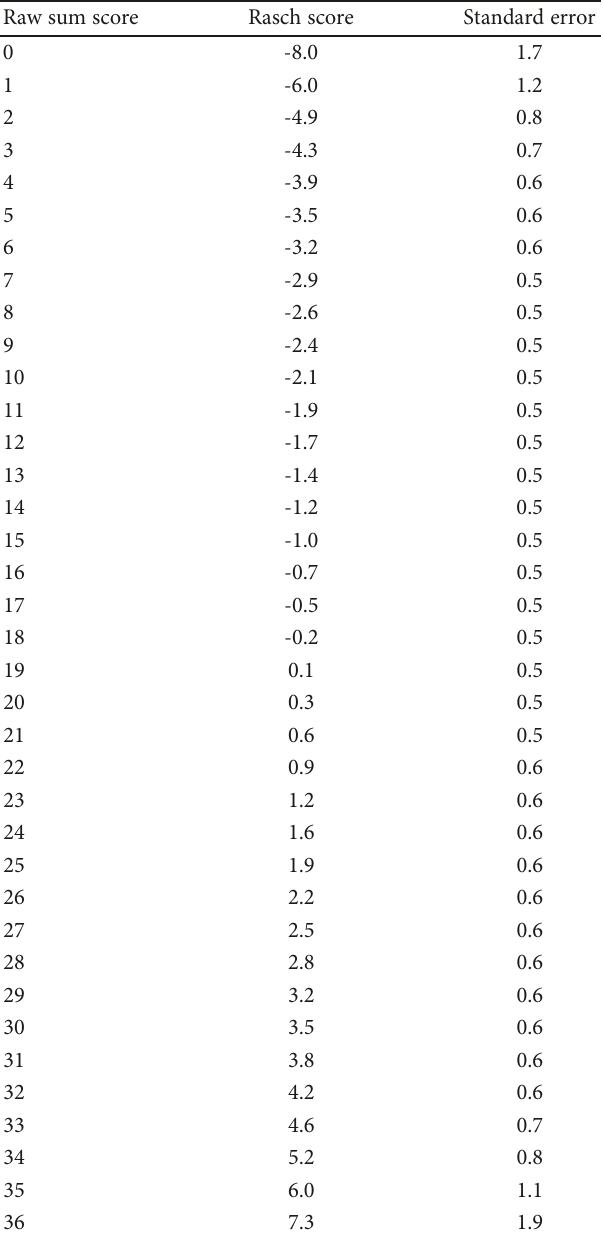
Table 3: Raw sum scores, Rasch scores, and standard errors of the occupational therapy engagement scale